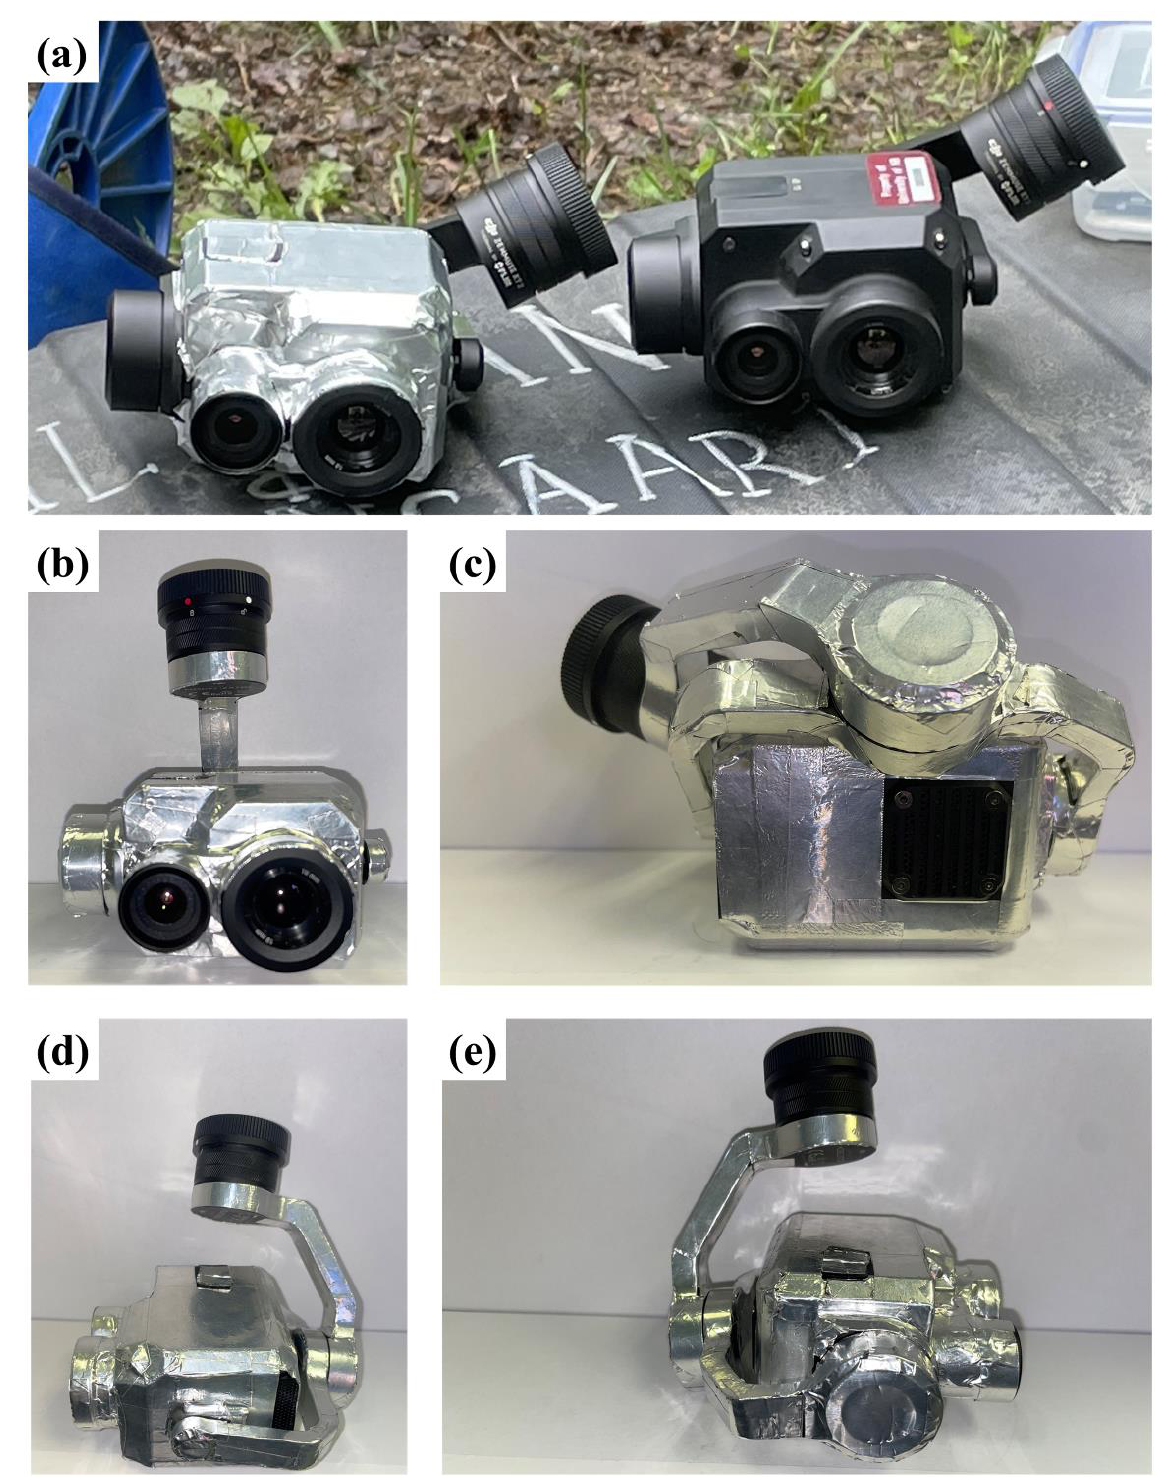
Figure 3. The two uncooled DJI Zenmuse XT2 sensors are shown in ( a ) where one sensor is wrapped in aluminum foil tape to provide solar irradiance shielding, and the other is left matte black as per the manufacturer’s default condition. Different viewpoints of the shielded sensor are presented in panels ( b – e ).